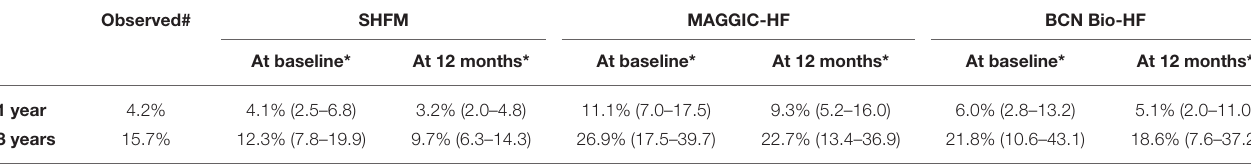
TABLE 3 | 1- and 3-year mortality risk estimation by studied HF calculators at baseline and after 12 months of follow-up. Observed#